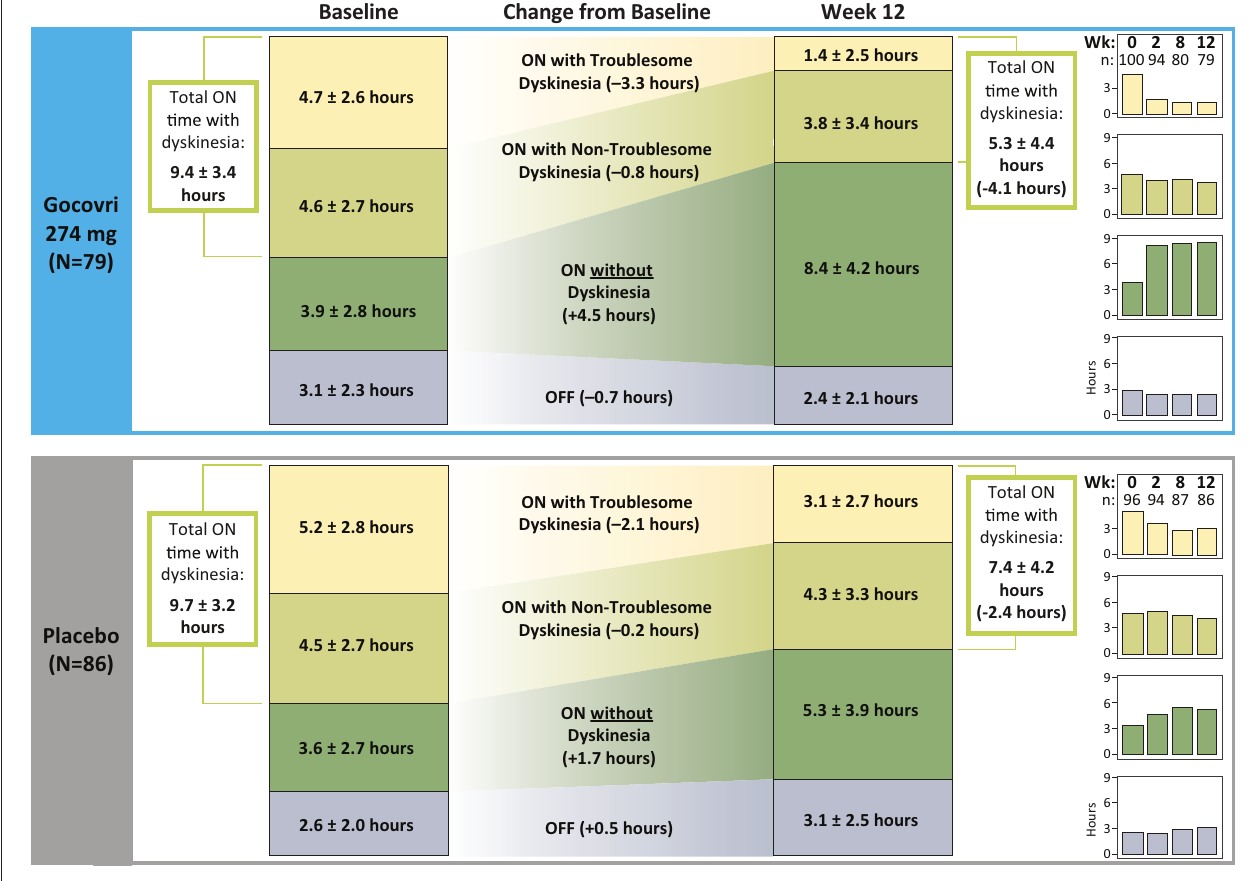
decreased from 9.7 ± 3.2 h at baseline to 7.4 ± 4.2 h at Week 12. The proportion of ON time with dyskinesia that was rated as troublesome (vs. non-troublesome) also showed a greater reduction for Gocovri, from 50% of total dyskinesia time at baseline to 26% at Week 12, compared with 54% at baseline and 42% at Week 12 for